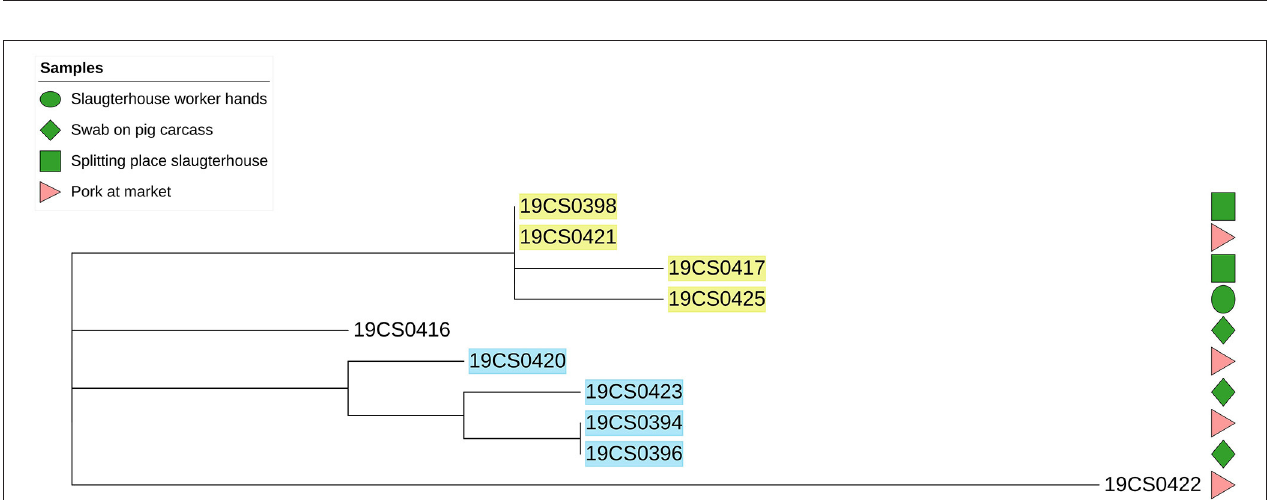
FIGURE 3 | Phylogenetic SNP-based tree of S. Rissen strains. Samples highlighted in different colors: clusters with more than one isolate. Green color figures: slaughterhouse samples, red color figures: market samples.